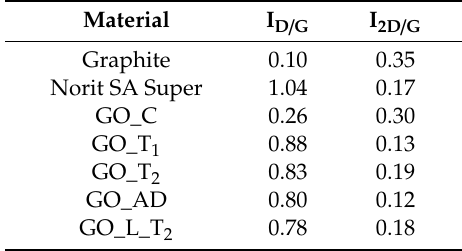
Table 2. Intensity ratio of D / G (I D / G ) and 2D / G (I 2D / G ) bands calculated from Raman spectra (Figure 4) of the carbon-based